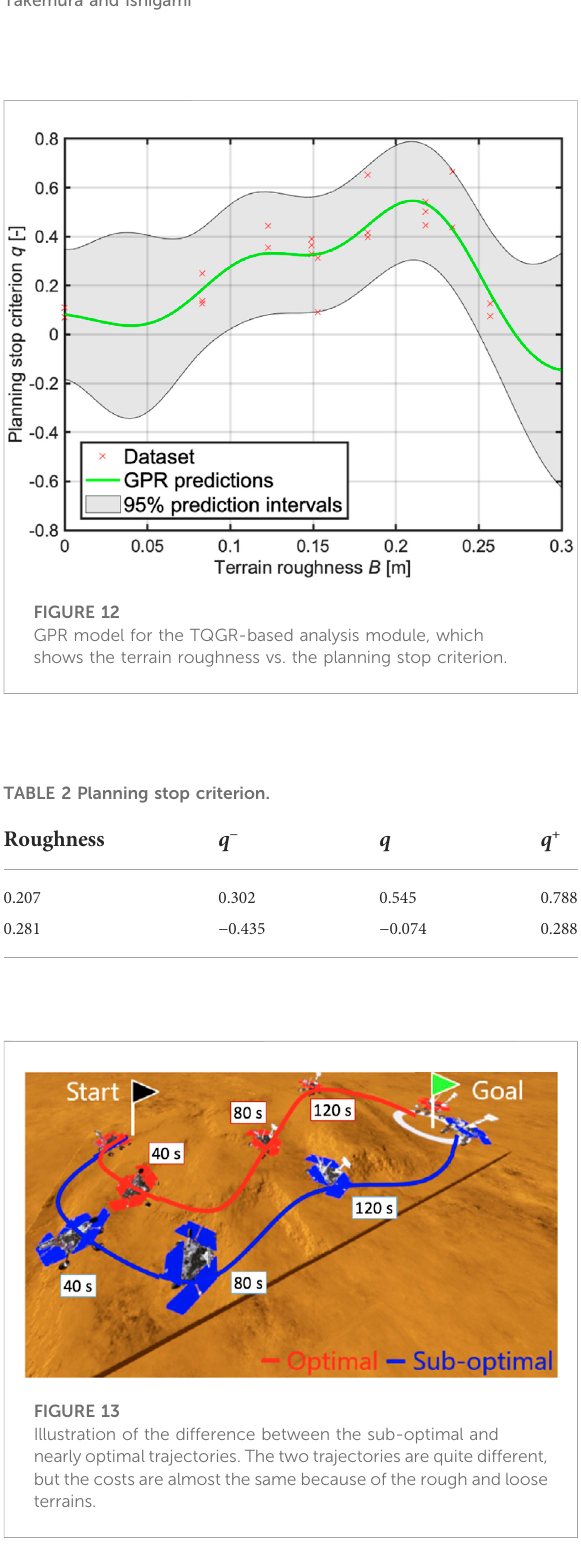
Figure 15 shows two metrics for each terrain map and each goal and the benchmark for the evaluation.